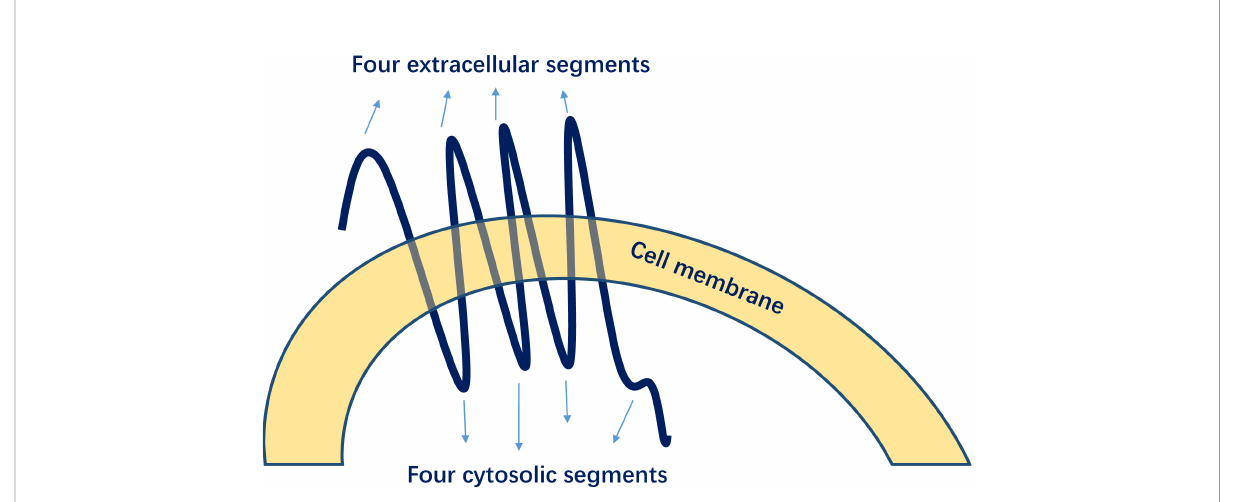
FIGURE 4 Structures of G-protein-coupled estrogen receptor 1